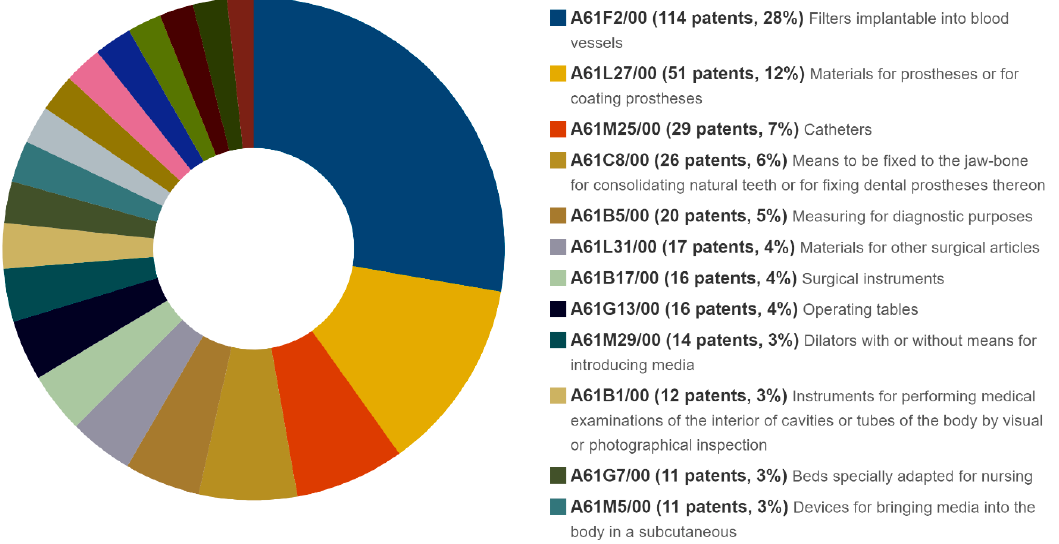
Figure 3. The most used International Patent Classification (IPC) codes for patents submitted by applicants from the Czech Republic in the medical devices area.